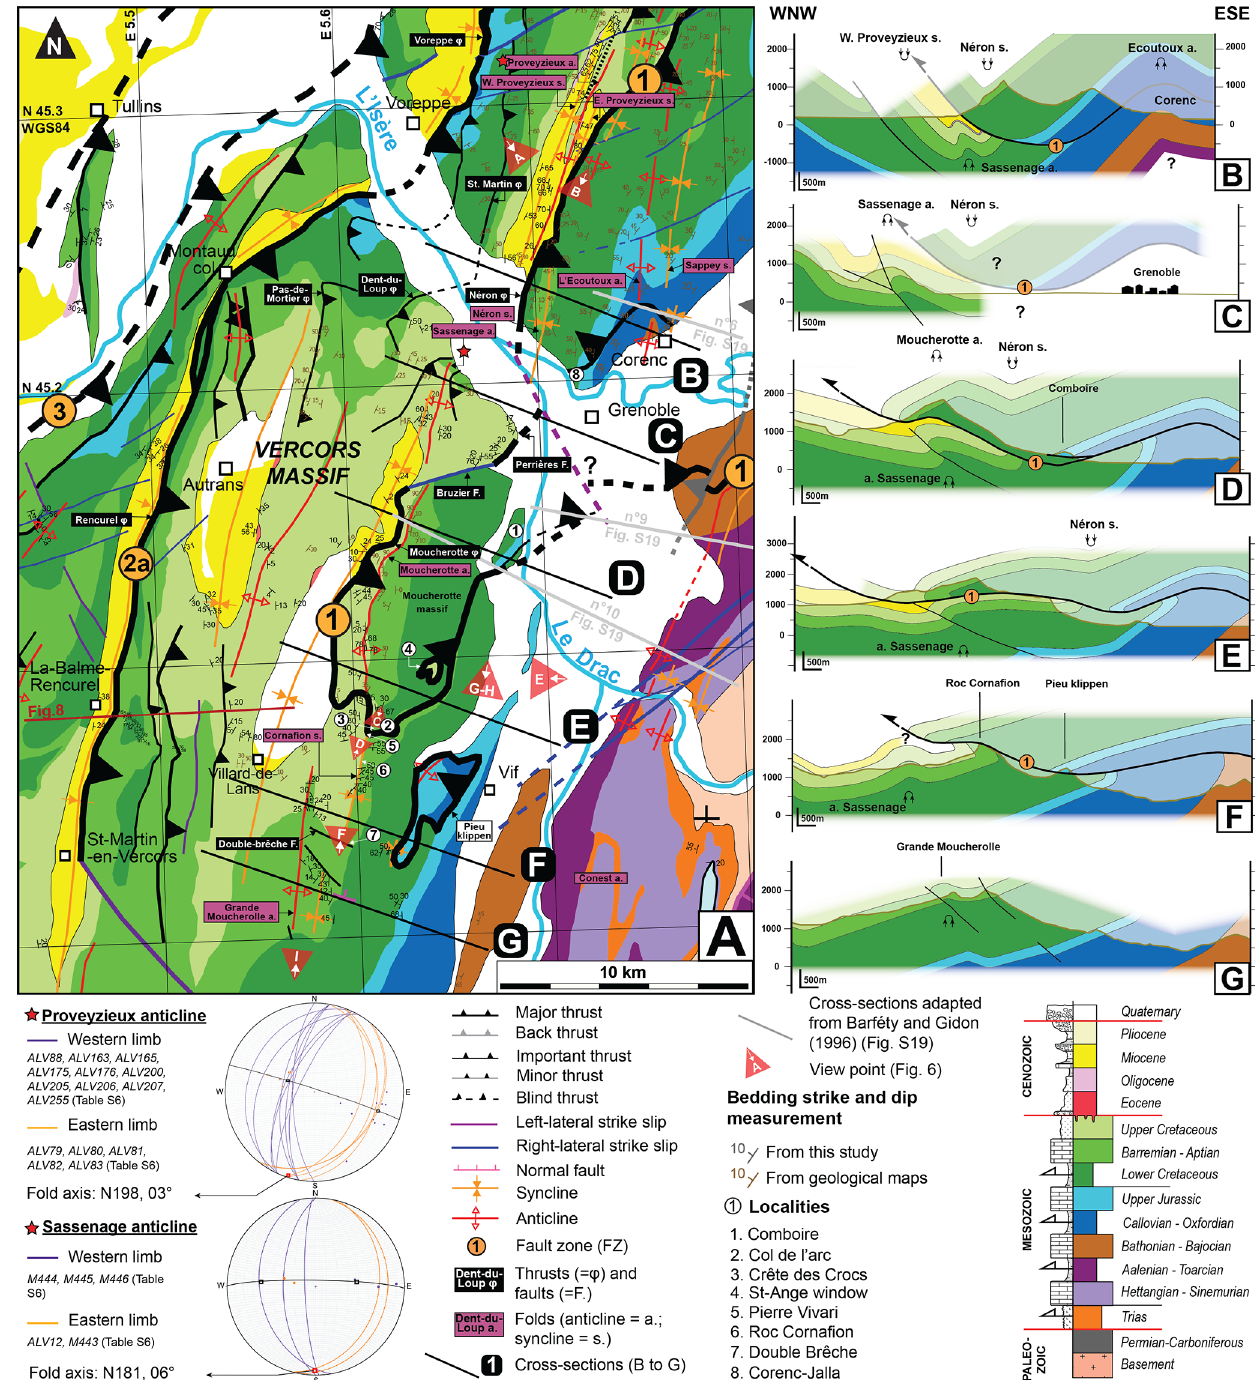
Figure 7. Structure of the Chartreuse oriental thrust (FZ1) in northern Vercors and southern Chartreuse. See Fig. 1 for the legend of the stratigraphy. (A) Structural map. Figure 6 viewpoints (A) to (I) are located. (B–G) Geological cross sections (see location in A ). The two stereo diagrams (Stereonet software; Cardozo and Allmendinger, 2013) at the lower left are plots of the stratifications and their poles in order to calculate the anticline